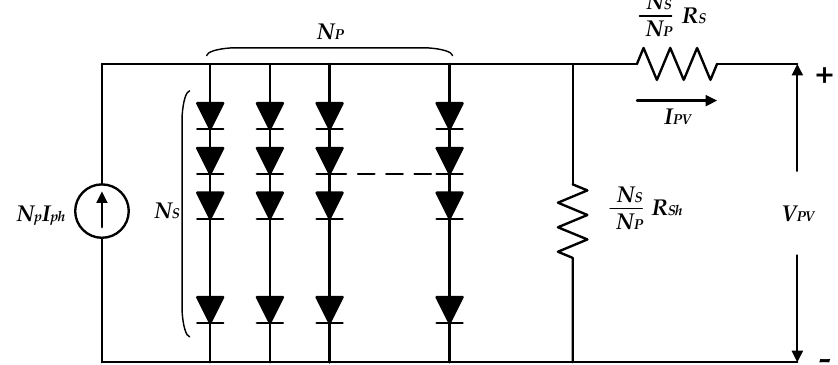
Figure 2. PV cell panel equivalent circuit.